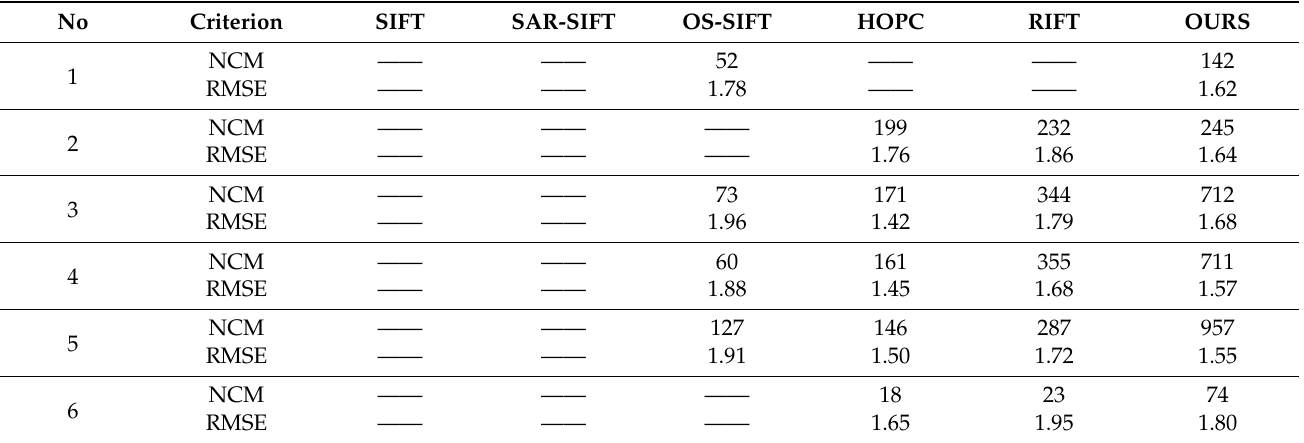
Table 2. The results of image